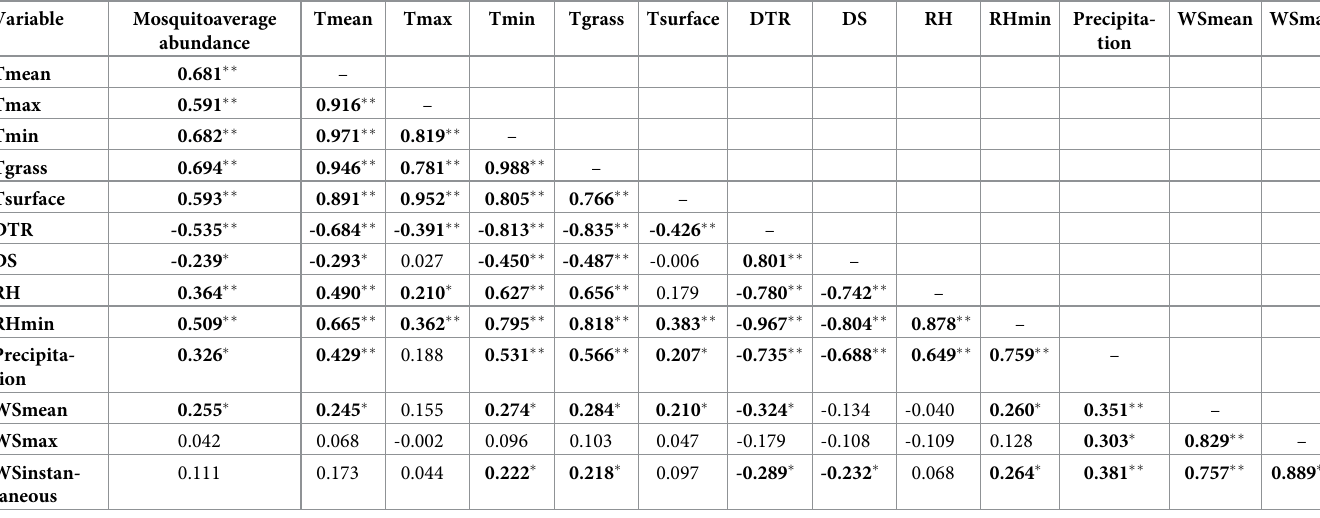
Table 3. Spearman’s correlations between Anopheles sinensis average abundance and climate factors in Goyang, Korea, from 23 to 43 weeks in 2008–2012. Variable Mosquitoaverage abundance